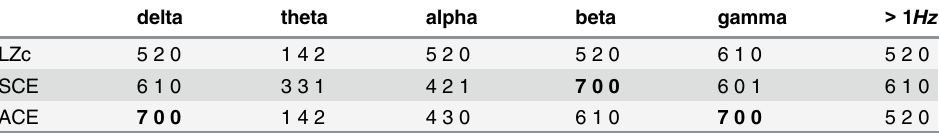
Table 2. Effect size comparison per measure and frequency band for WR/LOC. delta